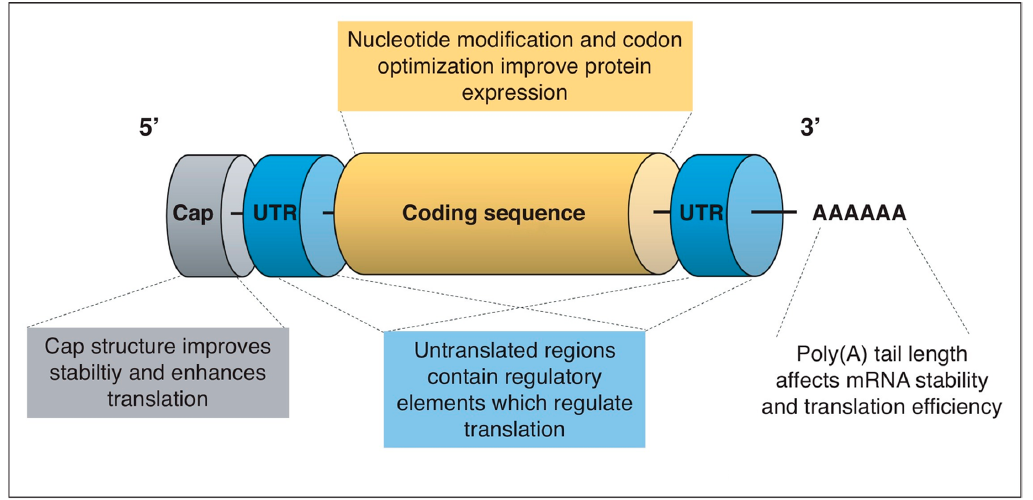
Figure 5. Optimization of mRNA sequence. (Adapted from [57]with rights and permissions).